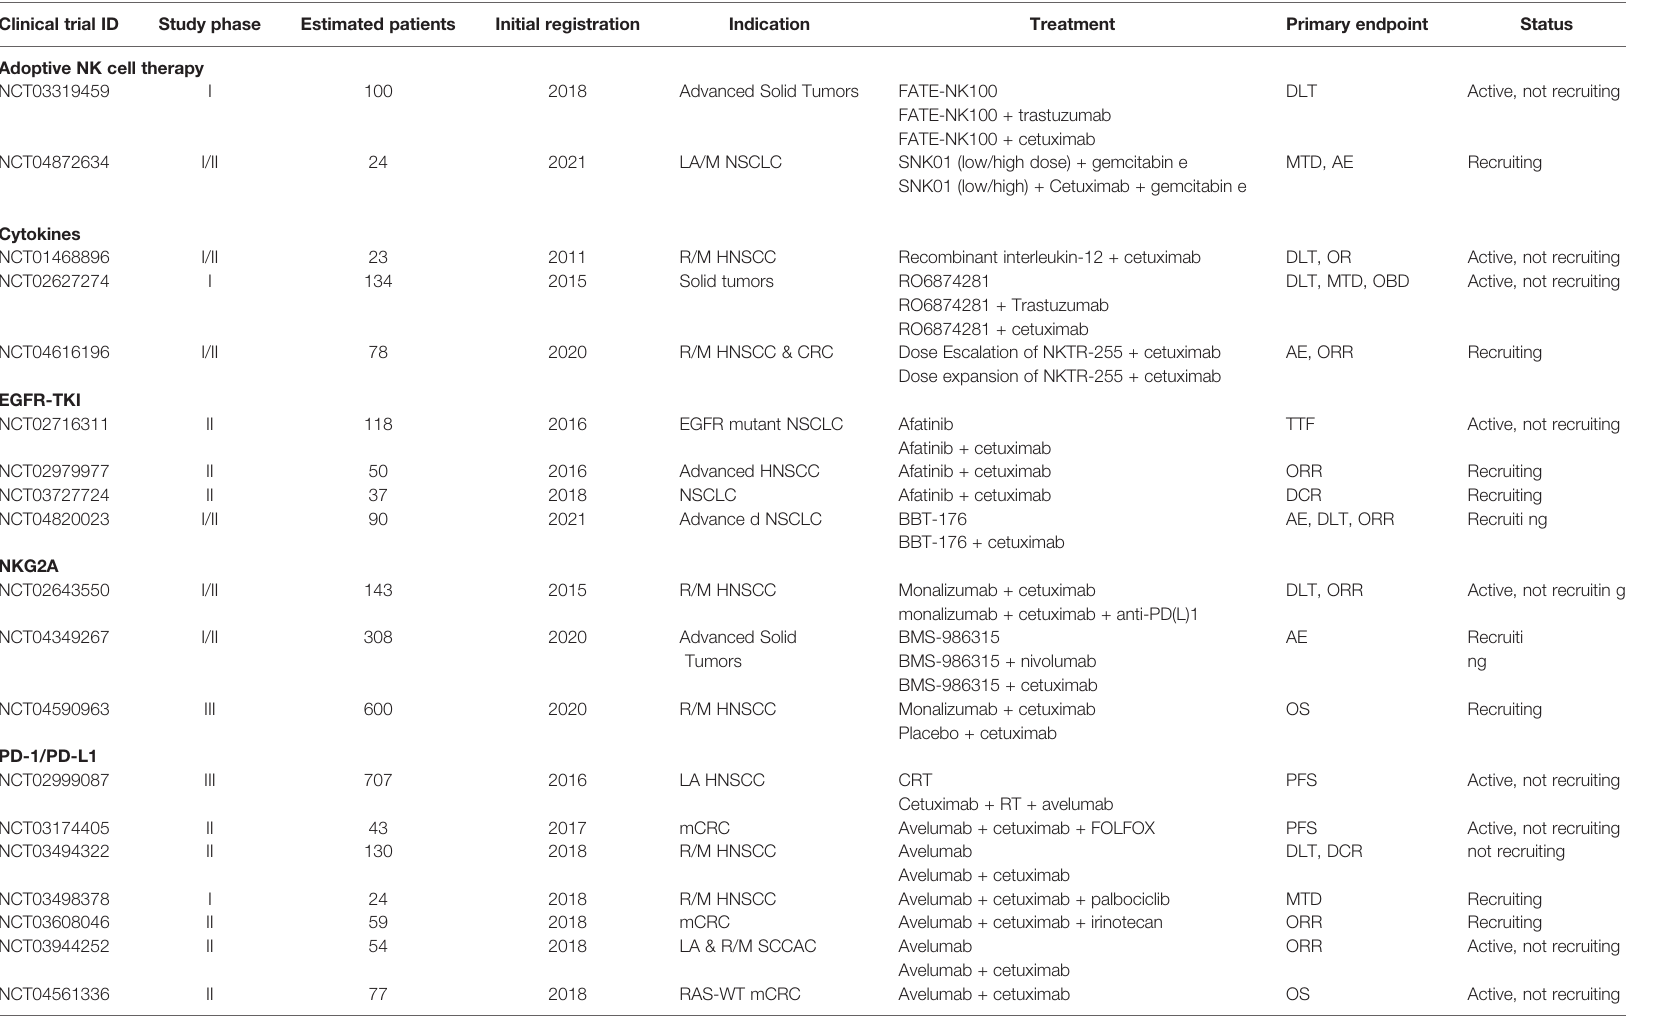
TABLE 3 | Active clinical trials evaluating cetuximab in combination with NK cell stimulating